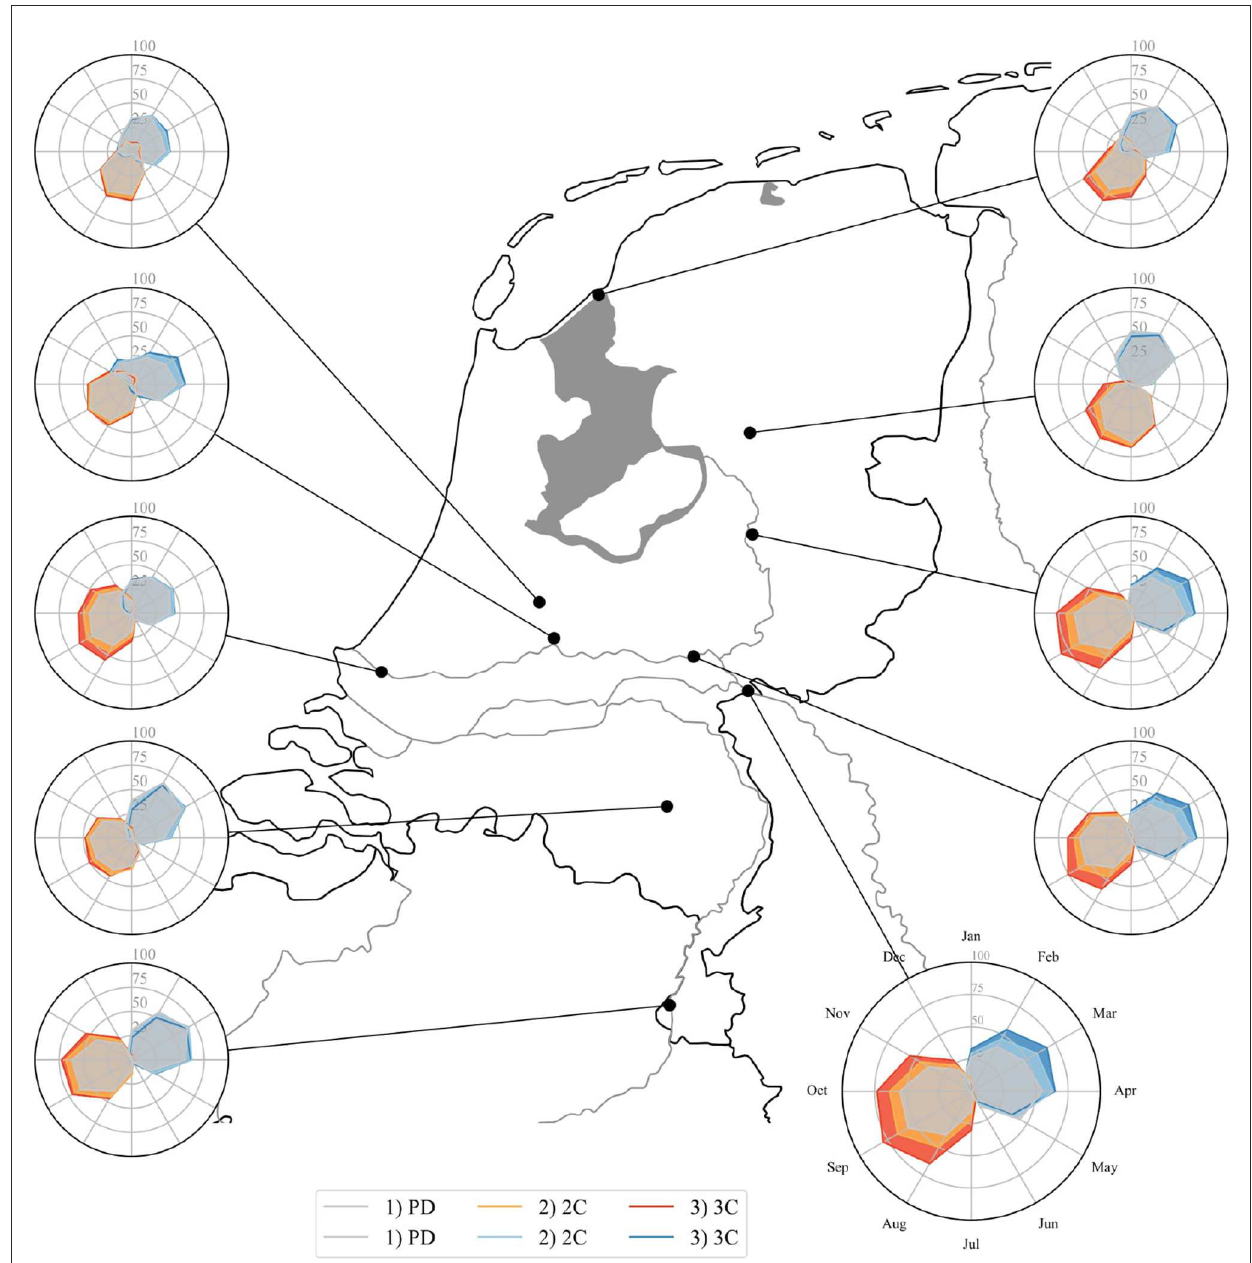
FIGURE6 Seasonal patterns in percentage of low and high flows for different stations and scenarios PD, 2C, and 3C, based on results from LSTM model. PD values for both high and low flows are represented by the gray shaded areas. Low flows for 2C are highlighted in orange and for 3C in red. High flows for 2C are shown in blue and dark blue